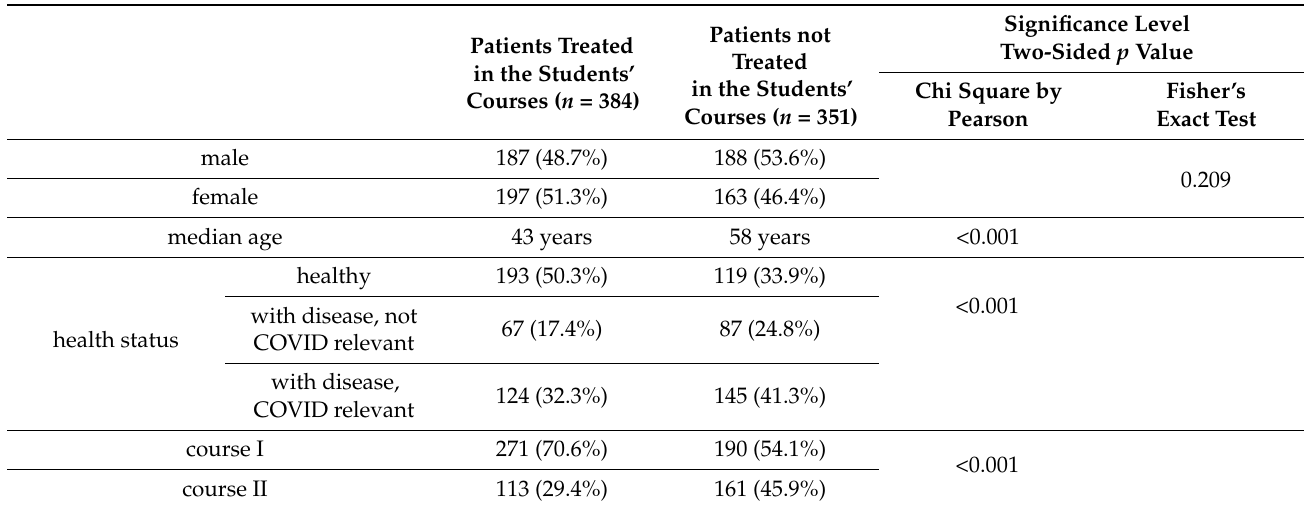
Table 1. Patients treated and not treated in the student courses in relation to gender, median age, health status and course affiliation.